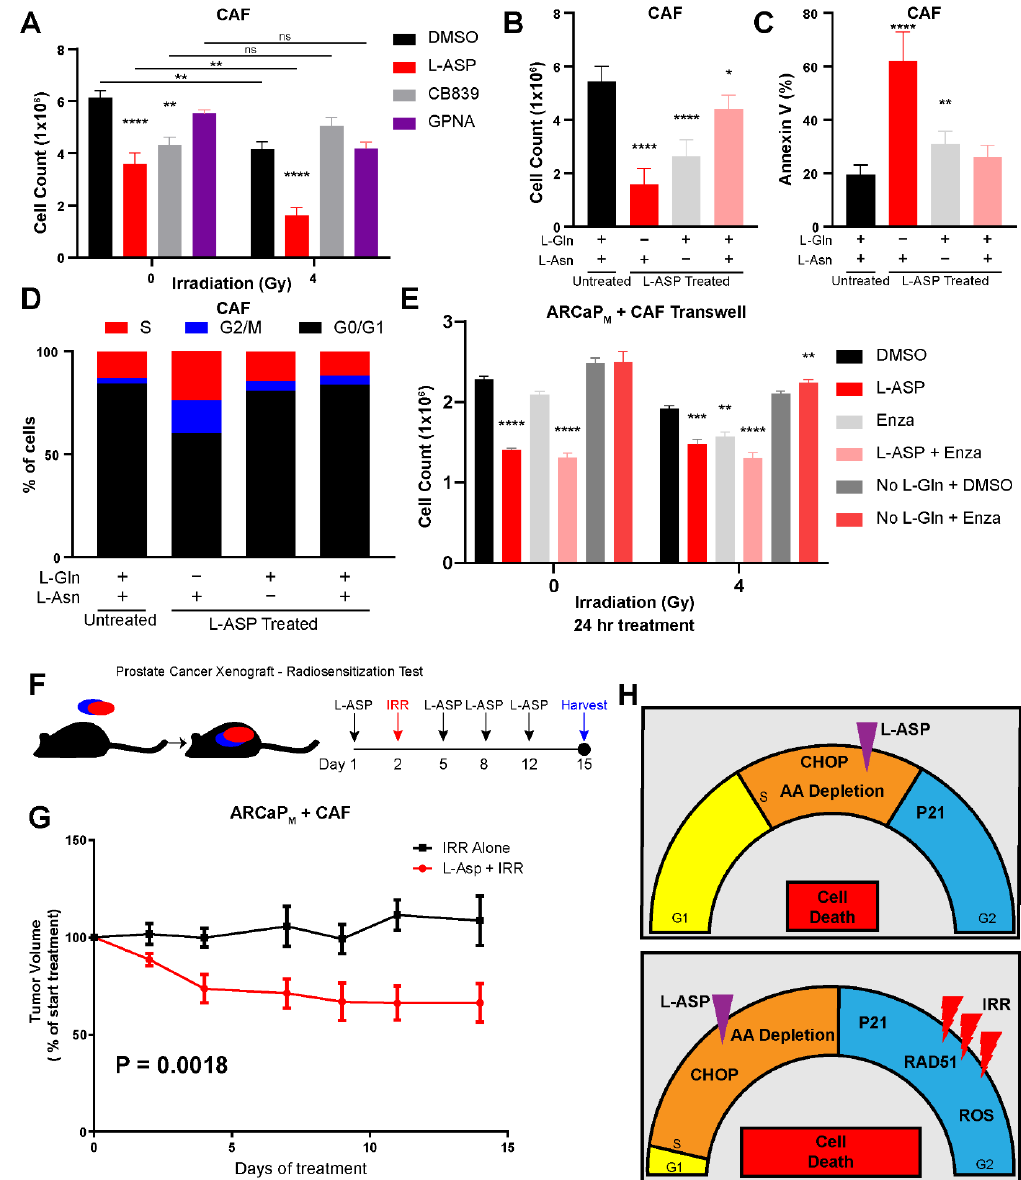
Figure 6. PCa radio-resistance mediated by CAFs can be countered by administering L-ASP. ( A ) CAFs were counted after administration of L-ASP (2 IU/mL), CB839 (1 µM), or GPNA (100 µM) 24 h after irradiation (4 Gy). ( B ) CAFs were counted after incubation with untreated and L-ASP-treated media with or without supplementation of L-Gln, L-Asn, or both. ( C ) Cells treated under the same conditions were subjected to FACS analysis for annexin V expression. ( D ) Cell cycle analysis was performed on CAFs following incubation with untreated and L-ASP-treated media with or without supplementation of L-Gln, L-Asn, or both. ( E ) ARCaP M cells co-cultured with CAFs in a trans-well were counted following incubation in L-ASP-treated media supplemented with enzalutamide (10 µM) and/or 2 mM L-Gln. Irradiation status of the co-cultures is indicated. ( F ) Schematic overview of xenograft experiment where athymic nude mice were grafted with ARCaP M and CAFs in a 1:3 ratio subcutaneously. ( G ) Mice were administered L-ASP (125 IU) or vehicle prior to and after receiving irradiation (5 Gy) as indicated ( n = 6). Tumor volume fold change was normalized to the first dose of L-ASP. Multiple comparison ANOVA was performed. ( H ) A graphic shows the revealed mechanism of how L-ASP acts as a radio-sensitizer in prostate tumors. All studies are reported as a mean of at least three independent experiments (* p < 0.05, ** p < 0.01, *** p < 0.001, **** p <